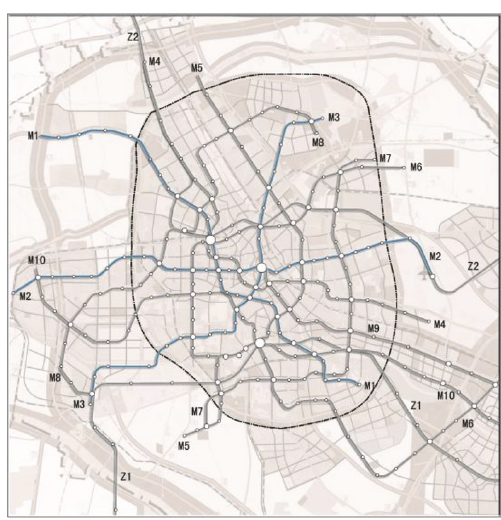
Figure 1: The urban rail transit line planning network of Tianjin